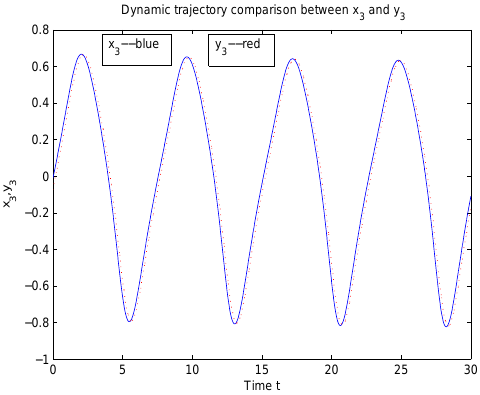
Figure 9. Computer simulations of synchronization between x 2 and y 2 for α = 1.